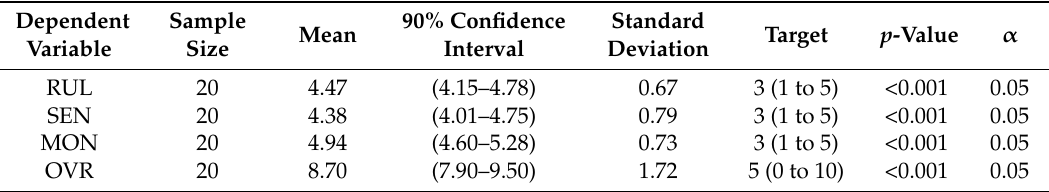
Table 7. Results of statistical tests.